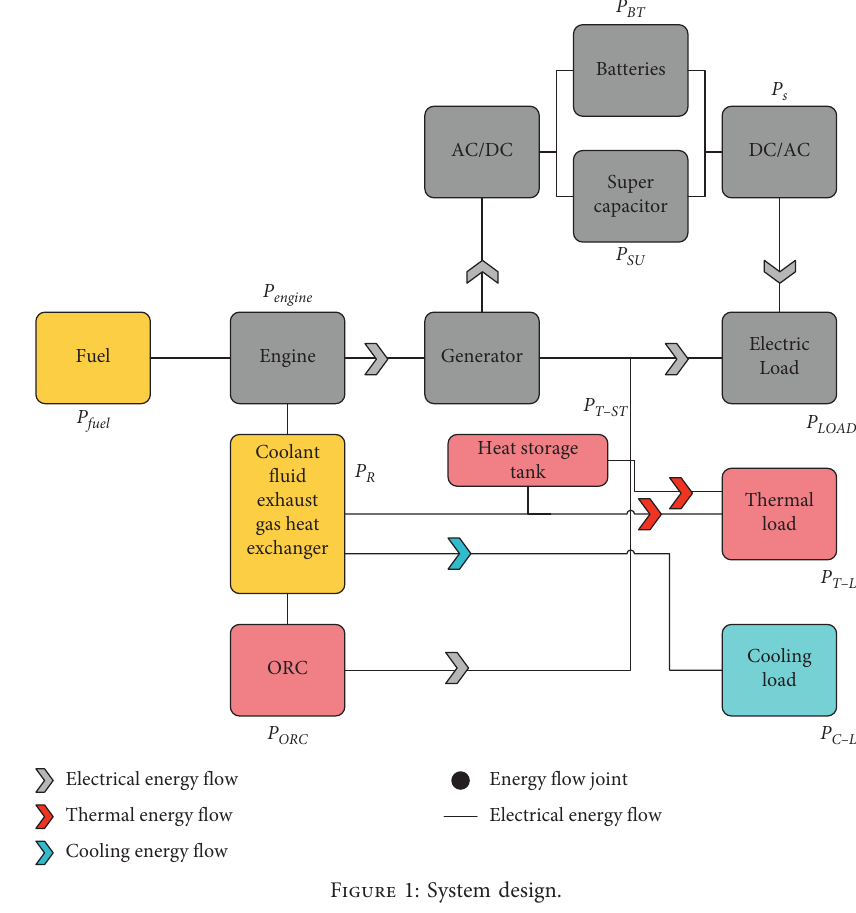
Figure 1: System design.